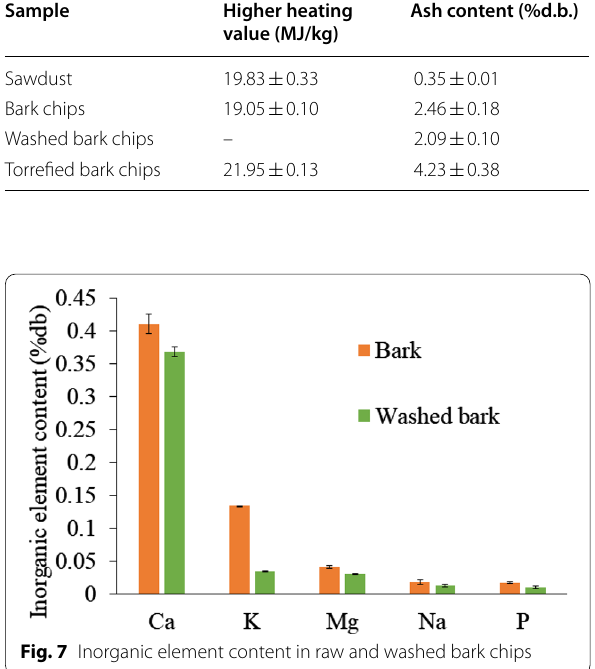
Fig. 7 Inorganic element content in raw and washed bark